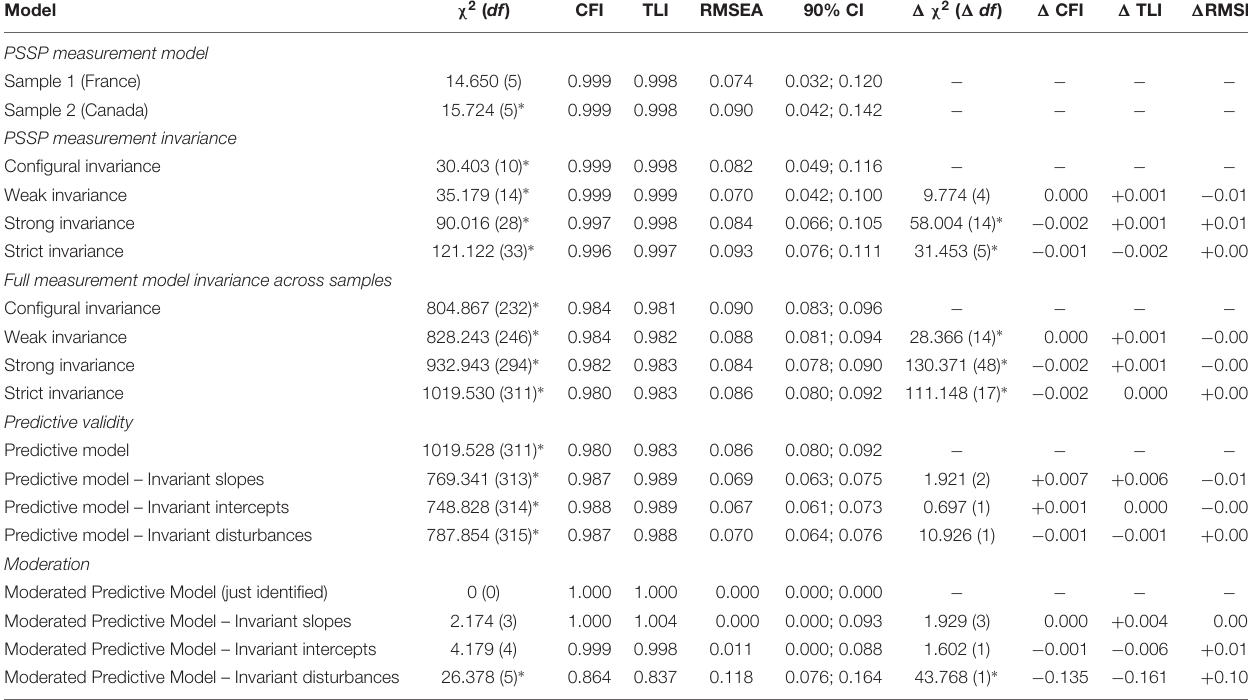
TABLE 2 | Fit Indices for the Models Estimated in Study